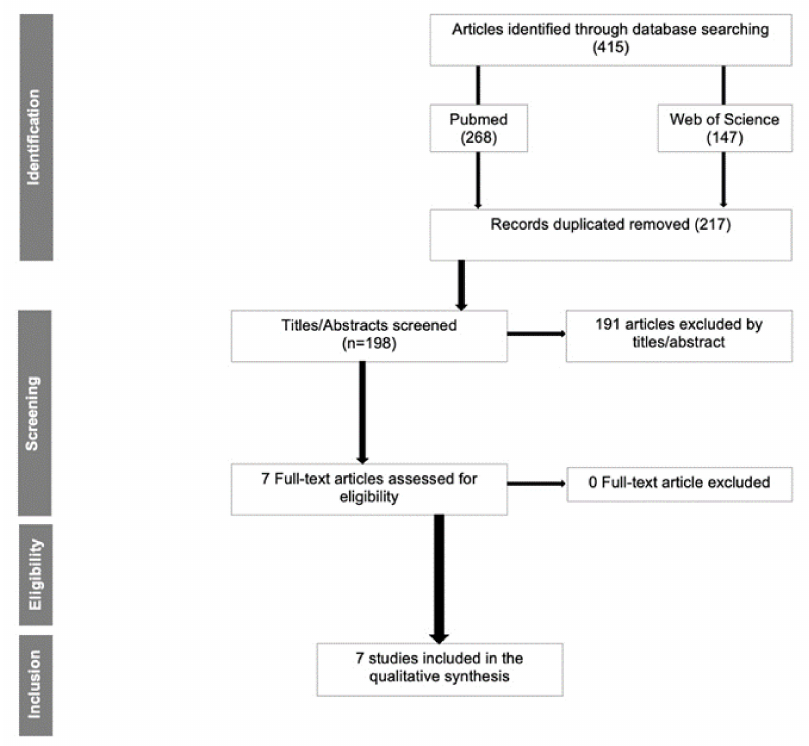
Figure 1. Flow diagram for the search strategy and selection process for included